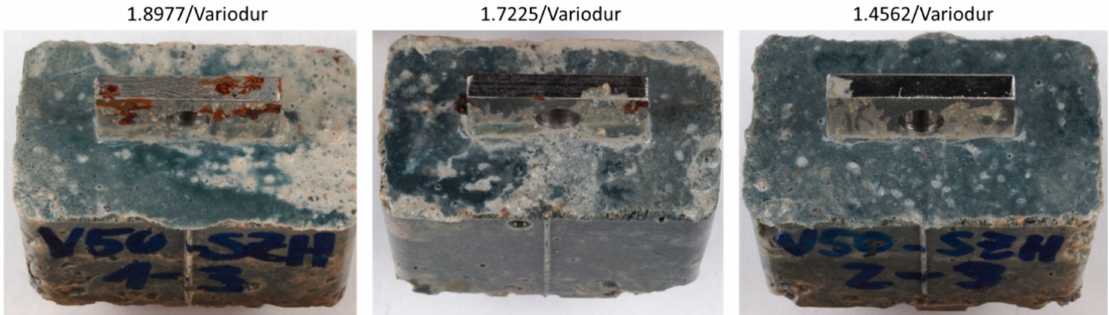
Figure 6. Steel/Variodur specimens after hydrating for 28